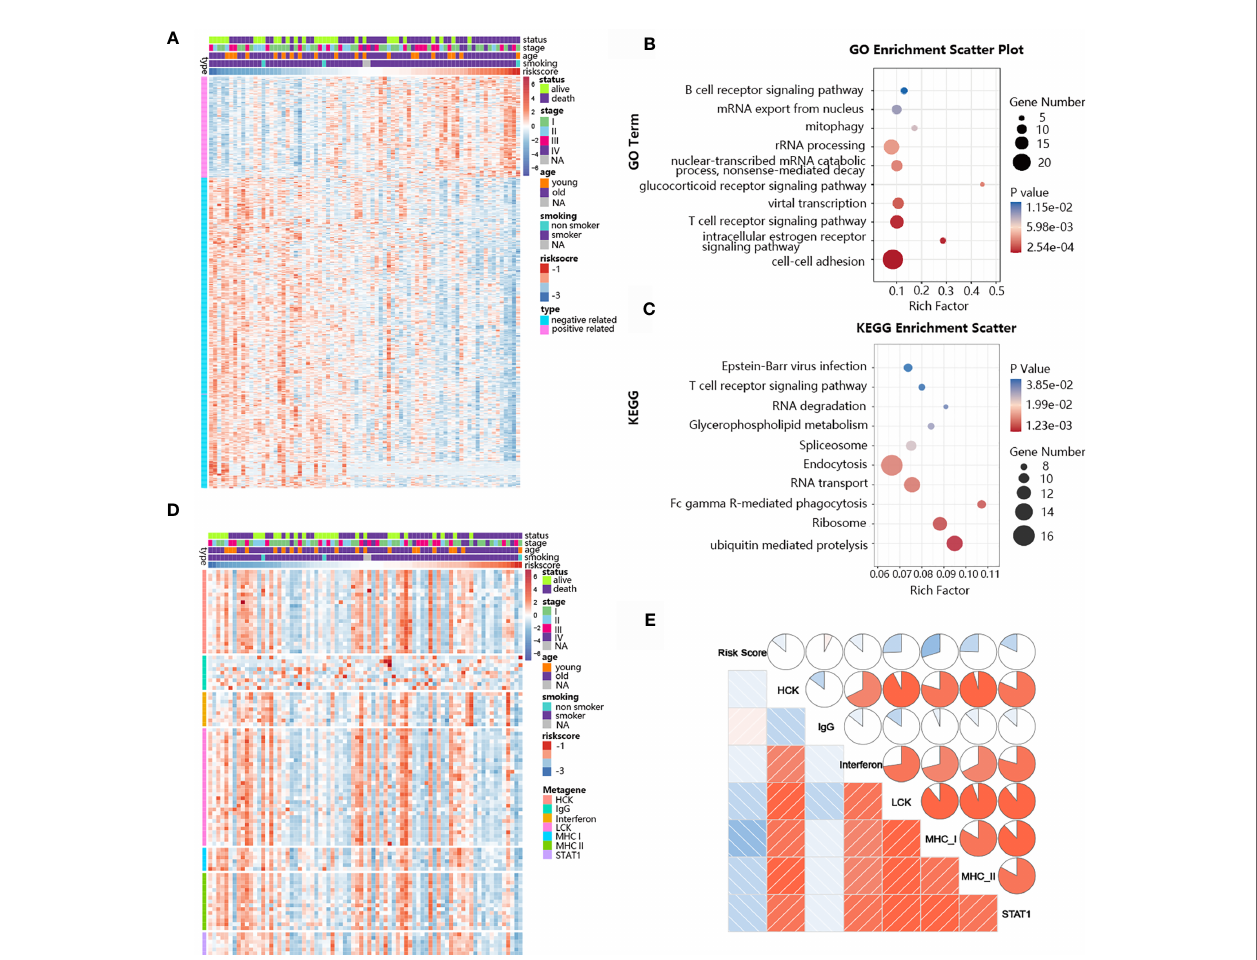
FIGURE 6 | Biological pathways and in fl ammatory activities of the TNF family-based signature in SCLC from GO and KEGG pathway analyses. (A) The most highly associated genes from the TNF family based-signature in SCLC patients from training cohort. (B) Gene enrichment with GO terms of the identi fi ed genes. (C) Gene enrichment with KEGG terms of the identi fi ed genes. (D) Heatmap of the expression pro fi les of seven metagenes. (E) Correlations between the risk score and seven clusters of